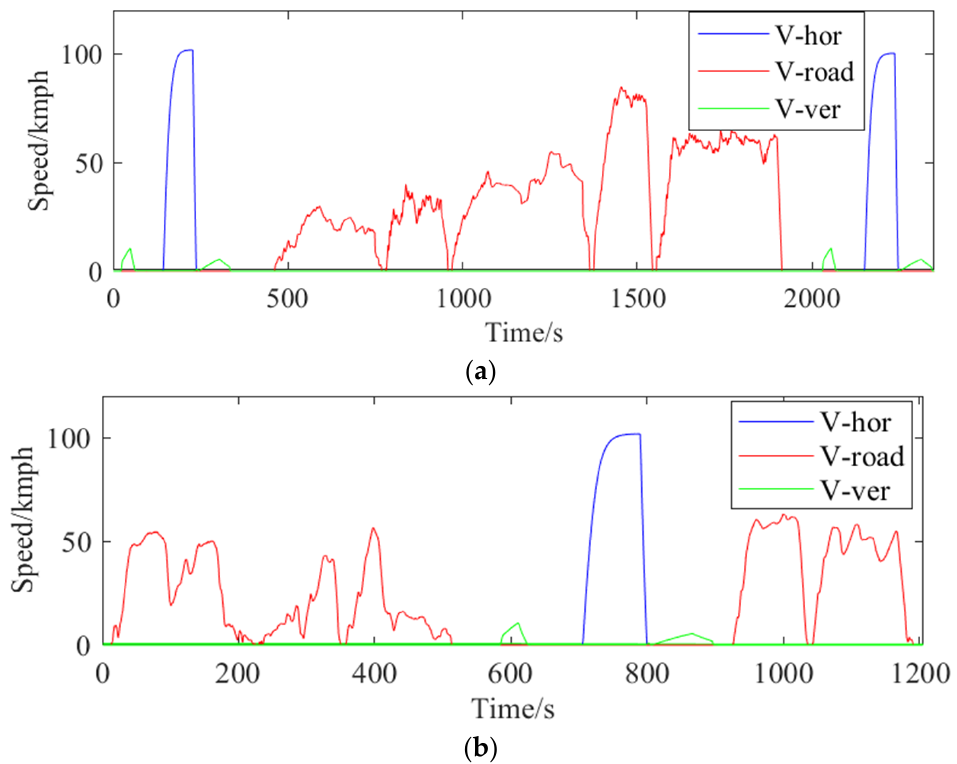
Figure 10. The HEAGV driving cycles. ( a ) Driving cycle A. ( b ) Driving cycle B. The red line represents the speed of the ground; the green line represents the vertical takeoff and landing speed; the blue line represents the speed of the horizontal cruise.